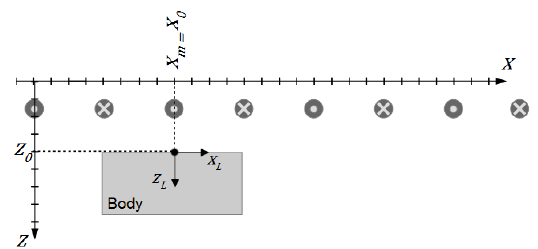
Figure A2 . Body with local coordinates and at arbitrary position 𝑥 𝑚 in front of the undulator